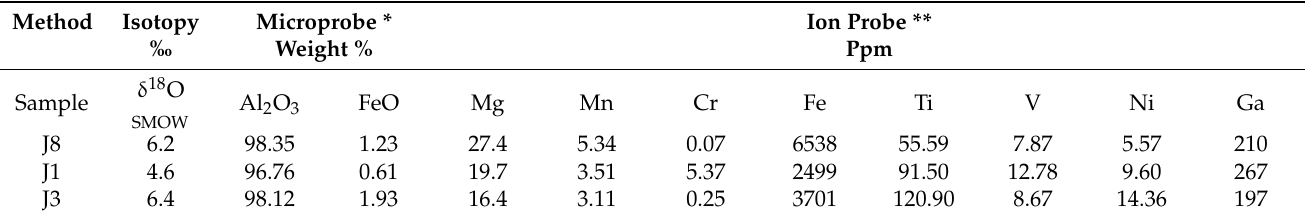
Table 1. Chemical composition and isotopy of the Naryn-Gol Creek